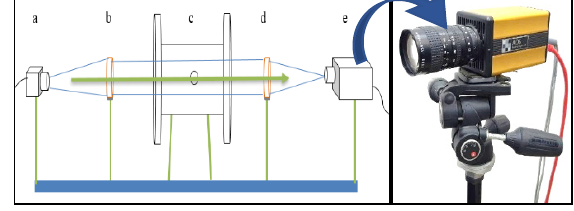
Figure 4. Schematic diagram for capturing unit a) illumi– nator, b) collimating lens, c) combustion chamber, d) de- collimating lens and e) high speed camera.